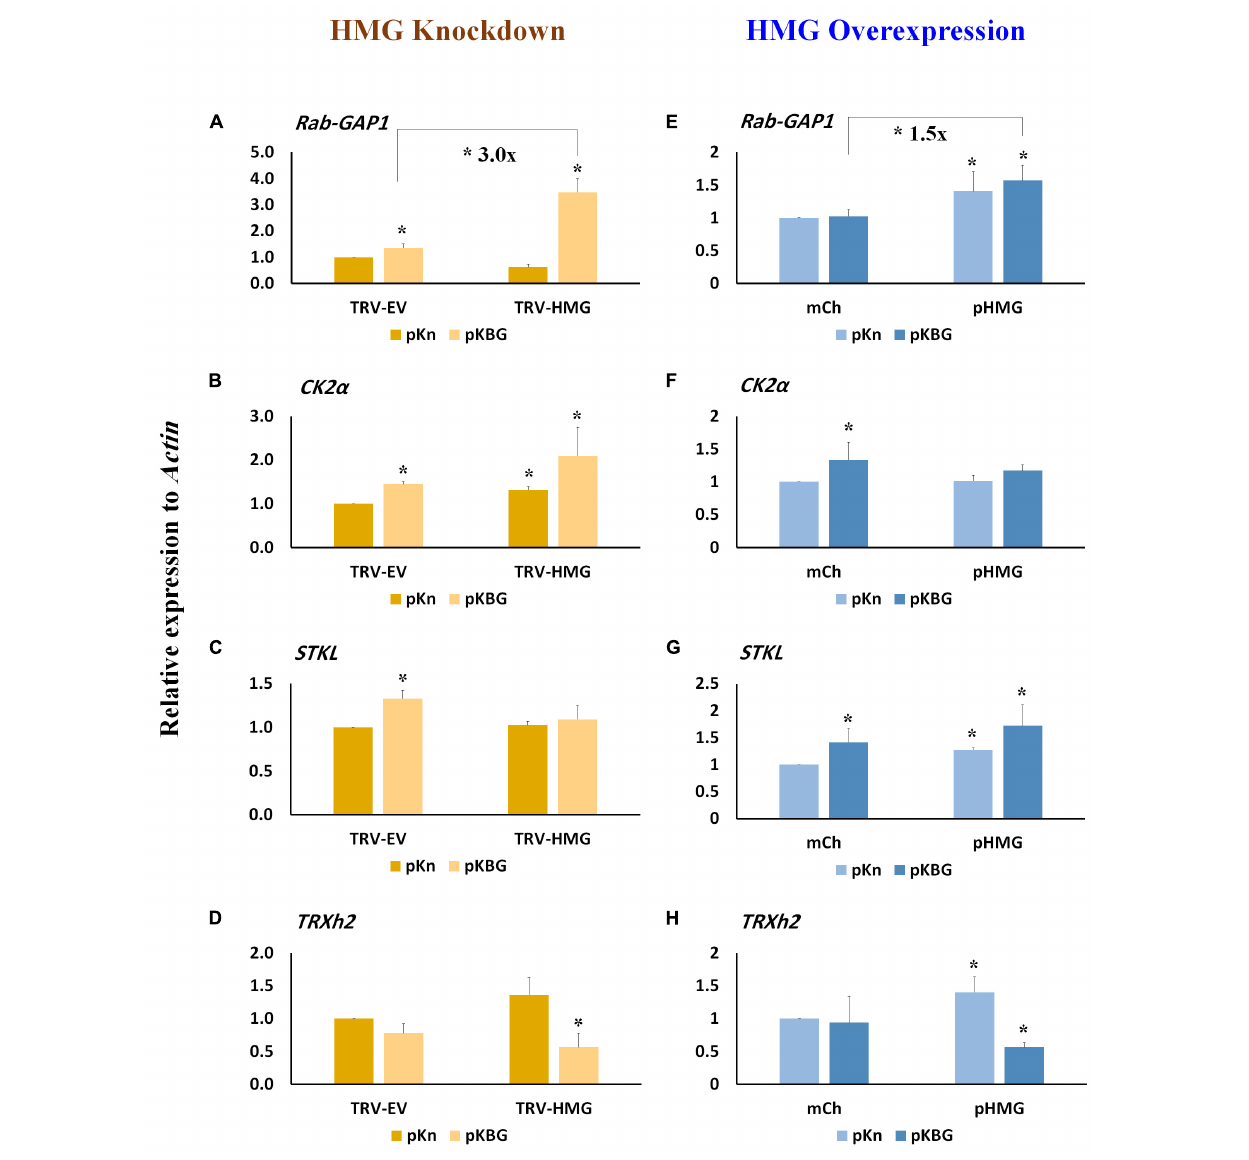
FIGURE 5 | Relative expression of host genes involved in BaMV movement in NbHMG1/2a- knockdown and -overexpressing plants. Transcript levels of RAB-GAP1 (A,E) , CK2 α (B,F) , STKL (C,G) , and TRXh2 (D,H) in N. benthamiana plants infected with pKBG or pKn and upon HMG being knocked-down or overexpressed, respectively. Expression level was measured in the BaMV-inoculated leaves at 6 dpi in both HMG-silenced and HMG-overexpressed plants. Actin was used as an internal control. Data represent the mean ± SD from three biological replicates. One-sided Student’s t- tests were performed to determine significant differences. Asterisks indicate significant differences relative to mock lines (infiltrated with pKn and pBin-mCherry), with * representing P <